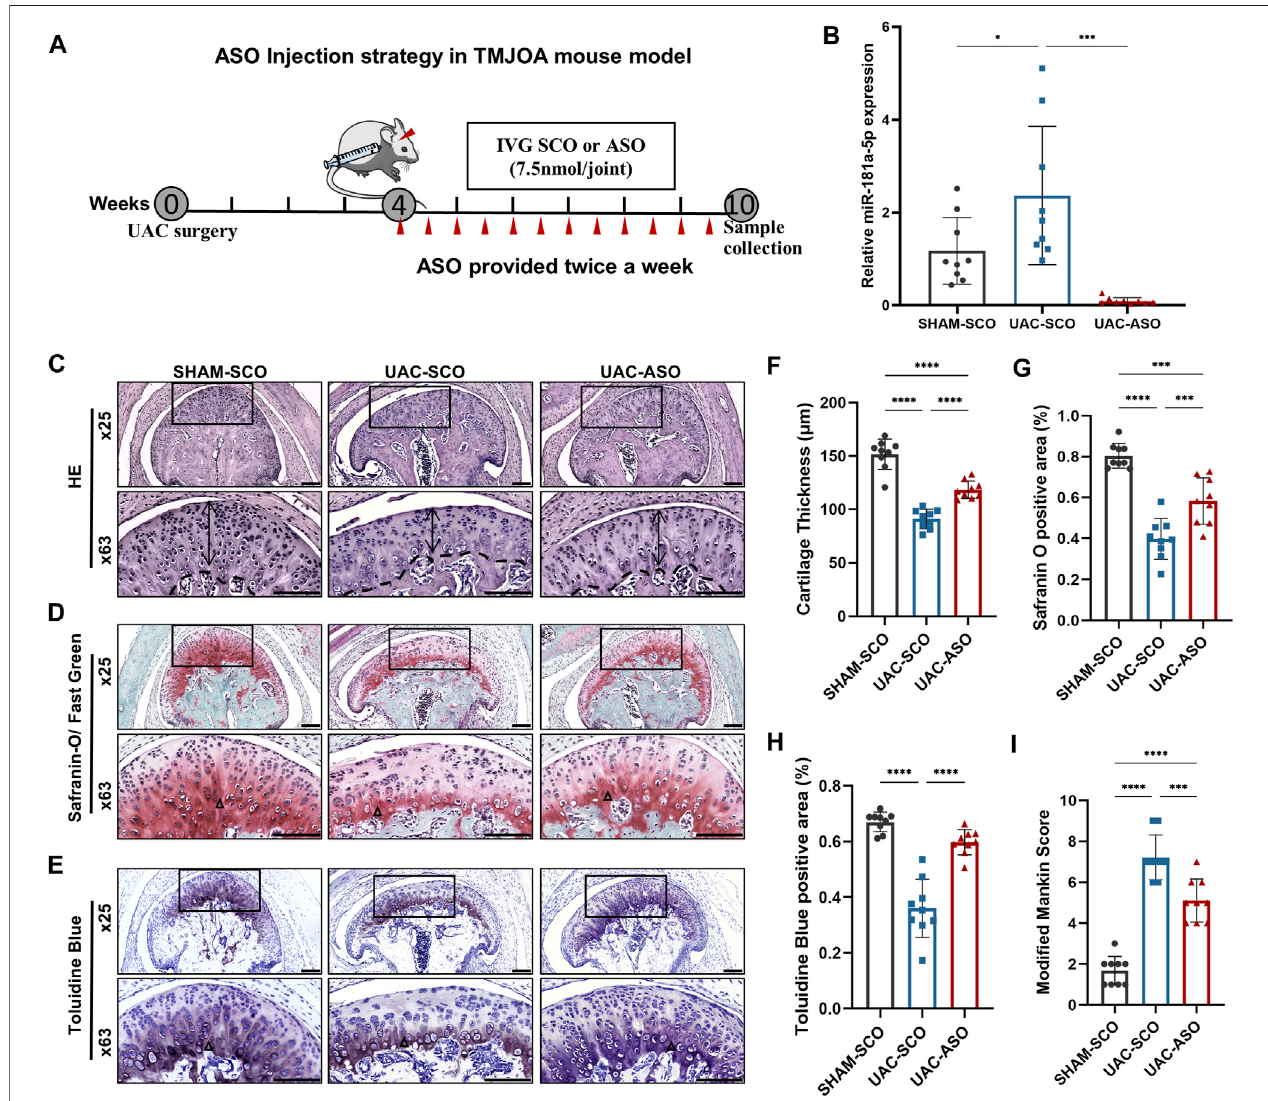
FIGURE 5 | MiR-181a-5p ASO local injection alleviated cartilage destruction in UAC-induced TMJOA mice. (A) Schematic of intra-articular injection. Four weeks after UAC, ASO or SCO was given in TMJ cavity twice per week for 6 weeks and samples harvested at 10 weeks. Red triangles represent and injection sites and time points. (B) Relative miR-181a-5p expression in SHAM-SCO, UAC-SCO and UAC-ASO condylar cartilage by qRT-PCRusing U6 as internal control. n = 9/ group. (C – E) Representative images showing HE, Safranin-O/ Fast Green and Toluidine Blue staining morphological change of the TMJ in SHAM-SCO, UAC-SCO and UAC- ASOmice.Scalebar:100 μ m.Forvisualcomparison,condylarheadsin (C – E) areadjustedtothesameorientation.Double-headarrowindicatesthecartilagethickness; black triangle represents staining positive area. (F) Comparison of average cartilage thickness ( μ m) in three study groups. n = 9/ group. (G,H) The percentages of the safranin O and Toluidine Blue positive area to the entire cartilage layer in SHAM-SCO, UAC-SCO and UAC-ASO groups were calculated. n = 9/ group. (I) The modi fi ed MankinscoresoftheseverityofTMJOAlesion inthreestudygroups. n =9/group. (F – I) DatapresentedasScatterdotplotwithbar(mean±SD).Statisticalanalysiswas performed using one-way ANOVA with a Tukey ’ s multiple comparisons test. * p < 0.05; ** p < 0.01; *** p < 0.001; **** p < 0.0001.